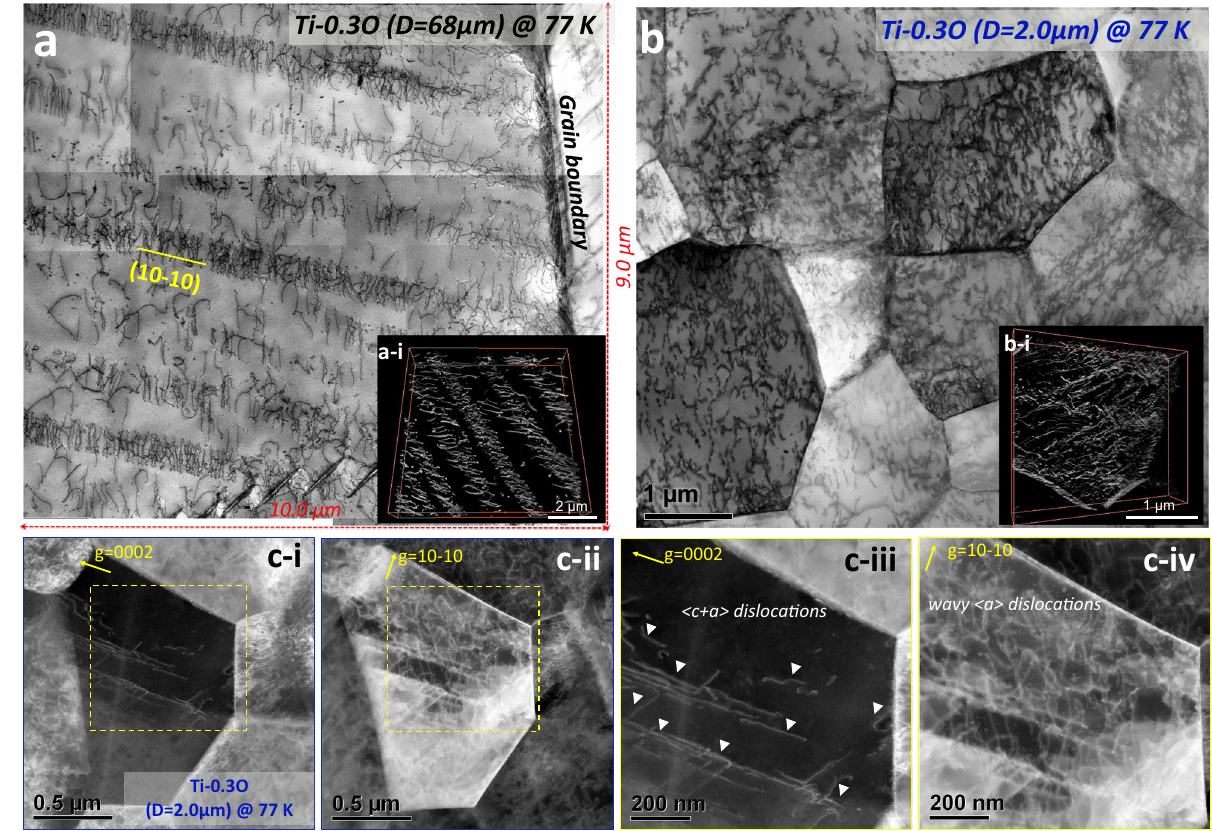
Fig.6|TEMcharacterizationofdislocationsinCGandUFGTi-0.3Odeformedat 77K.a Well-alignedplanardislocationslipalong (10-10)prismaticplanesintheCG Ti-0.3O alloy after tensile fracture ( ε f ~1.5%) at 77K. Inserted is a snapshot of dis- location tomography analysis, which con fi rms a planar dislocation arrangement in 3-dimensionalspace. b IntheUFGTi-0.3Oalloydeformedat77Kbyaplasticstrain of2.5%,dislocationsweremorehomogeneouslydistributedinsidethegrains.Inthe